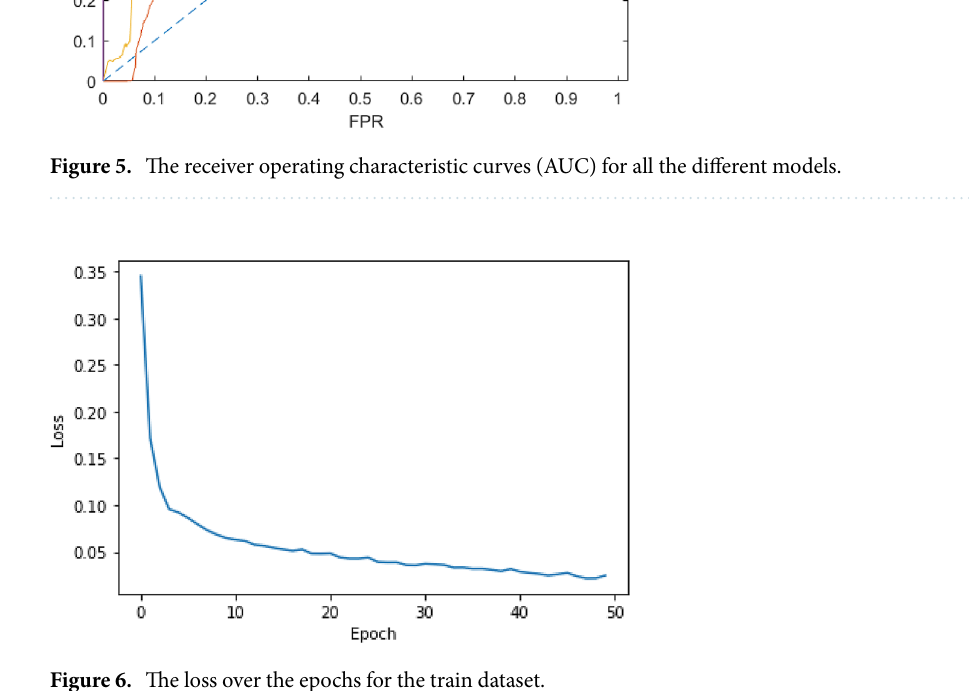
Figure 6. The loss over the epochs for the train dataset.